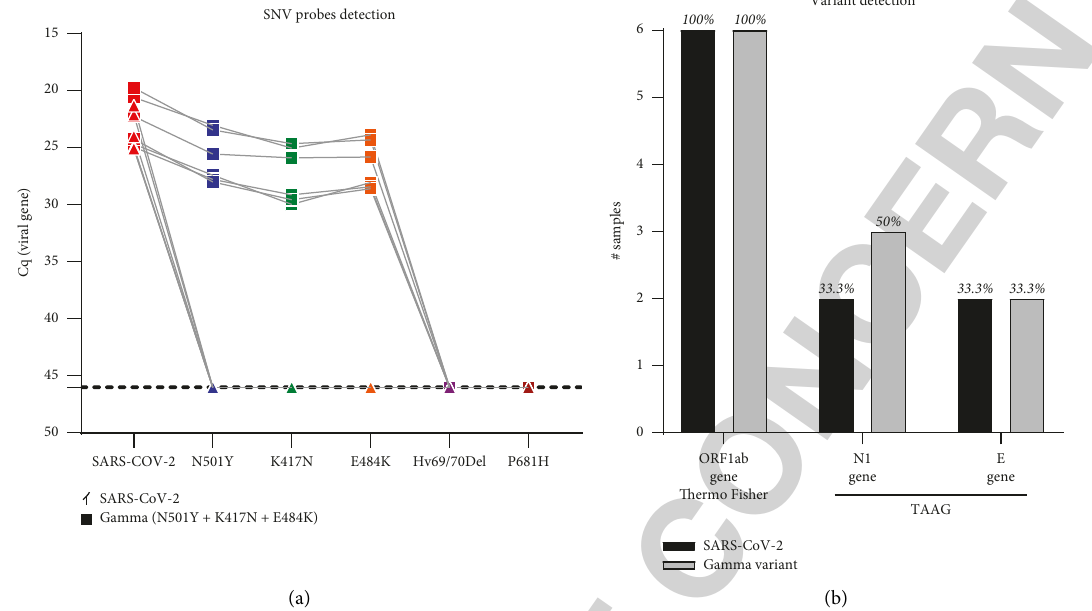
Figure 4: Impact of the TAAG diagnostic kit on the detection of SARS-CoV-2 variants. Twelve previously diagnosed SARS-CoV-2 positive samples by Thermo Fisher kit were randomly chosen and analyzed for the presence of SARS-CoV-2 variants by RT-qPCR. (a) Cq values for detected SNV probes associated with SARS-CoV-2 variants (N501Y, K417N/T, E484K, Hv 69/70 del, and/or P681H). When only the original SARS-CoV-2 variant was detected, it was denoted with triangles ( ▲ ). When the Gamma variant sample (N501Y, K417N/T and E484K probes positive amplification) was detected, it was denoted with squares ( ■ ). The other six samples showed no amplification for any of the SNV probes tested. (b) Summary of the diagnostic impact of the TAAG (N1 and E genes) and Thermo Fisher (ORF1ab gene) on the detection of SARS-CoV-2